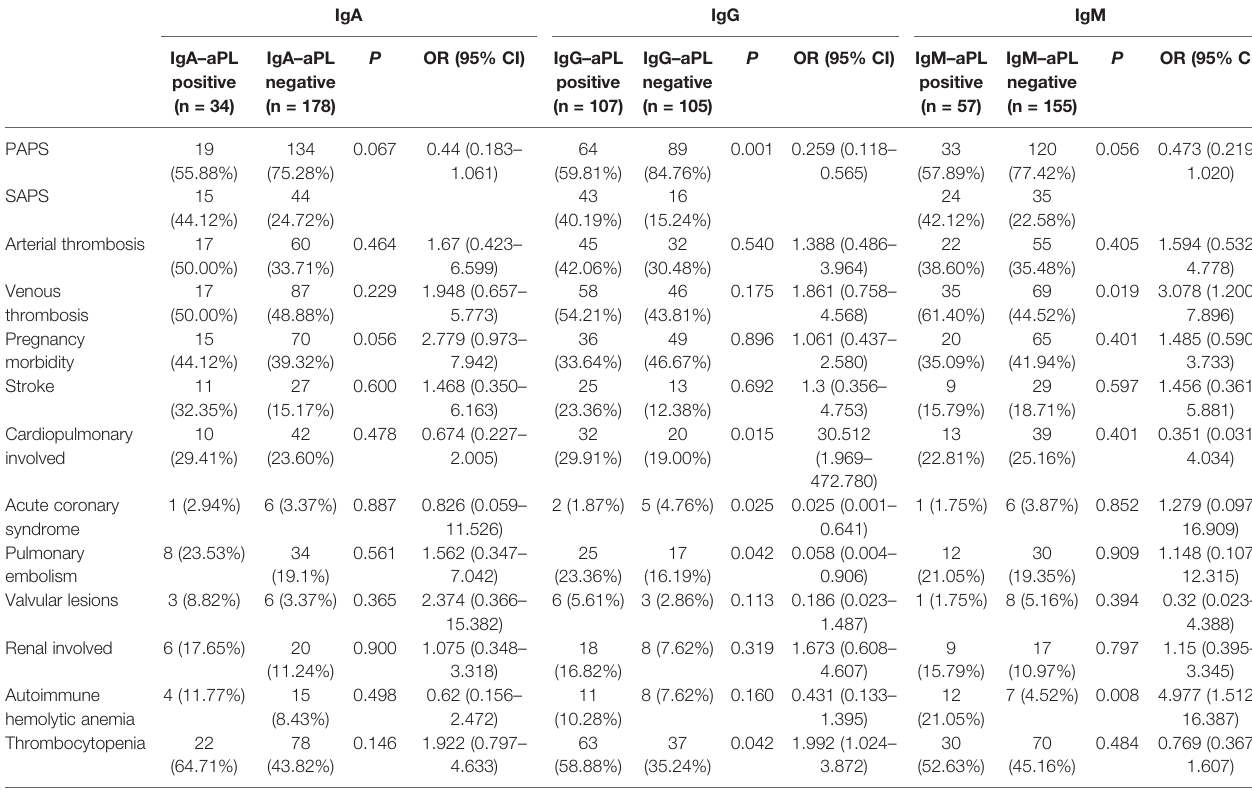
TABLE 5 | Associations between APS-related clinical manifestations of 212 patients with aPL